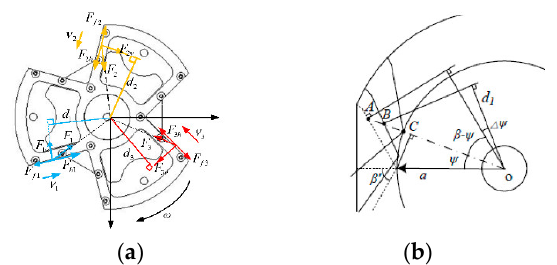
Figure 7. Illustrating the contact force between the active and passive docking mechanisms ( a ) anal- ysis of forces; ( b ) trajectory of locking